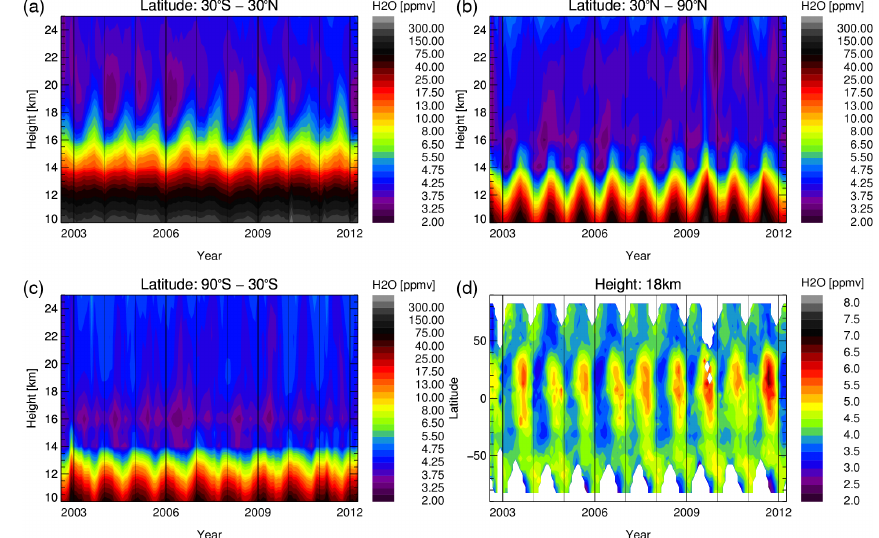
Figure 8. Time series of water vapour volume mixing ratios from SCIAMACHY limb measurements three latitude bands: 30–90 ◦ N, 30 ◦ S– 30 ◦ N, and 90–30 ◦ S and for all latitudes at 18km height. Area weighted means of 5 ◦ × 5 ◦ gridded